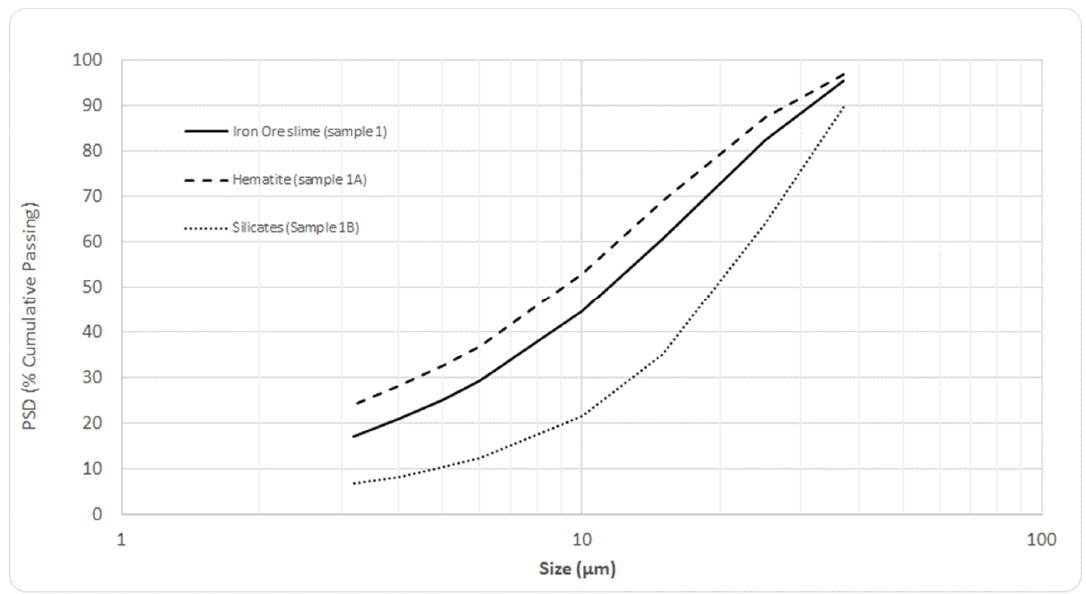
Figure 5. Comparative PSD between the iron ore slime (sample 1), hematite (sample 1A), and the silicates (sample 1B).